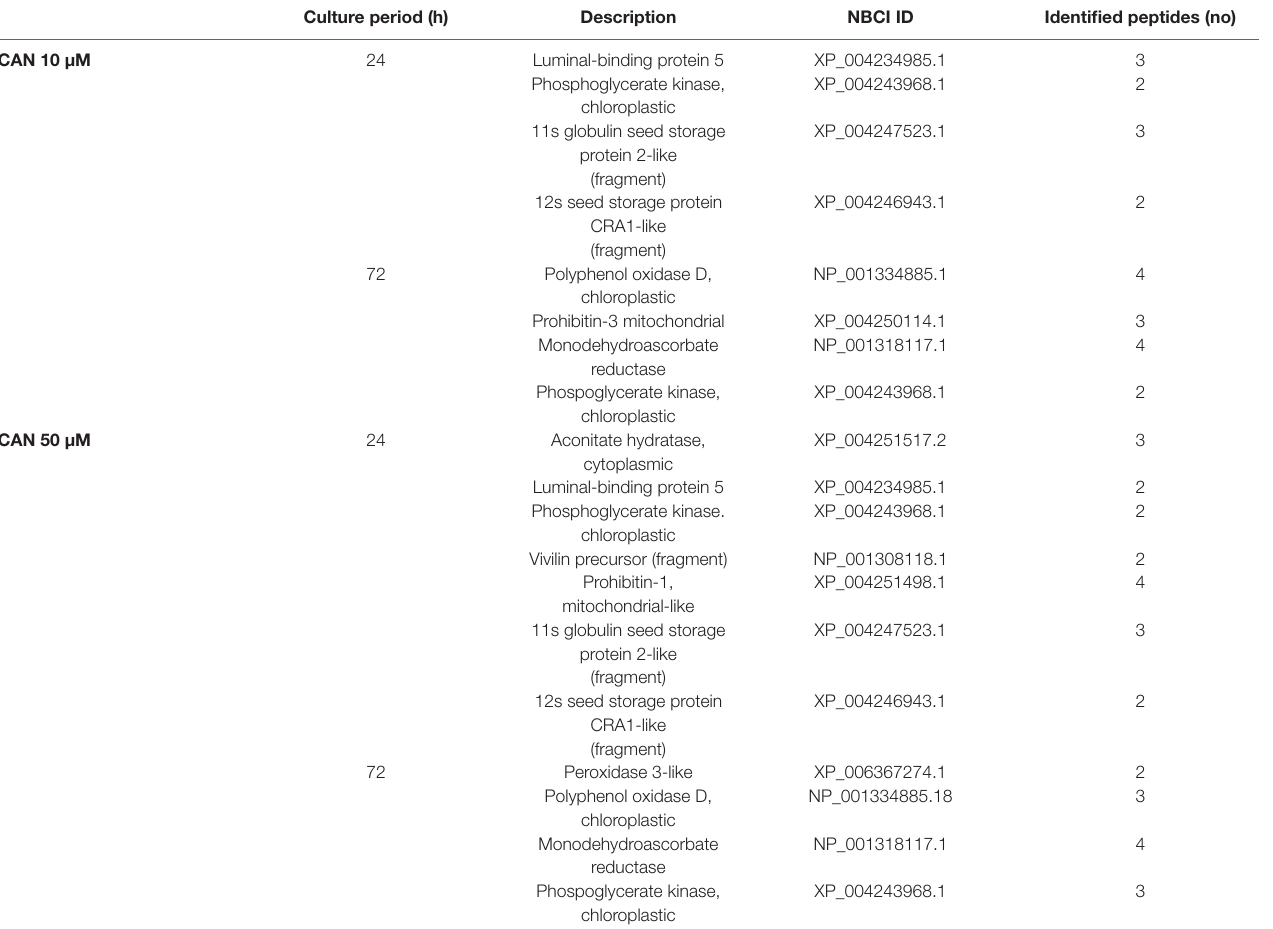
TABLE 3 | Matrix-assisted laser desorption/ionization MS/MS identification after trypsin in-gel digestion of the nitrated proteins of tomato roots treated with CAN (10 or 50 µM) for 24 or 72